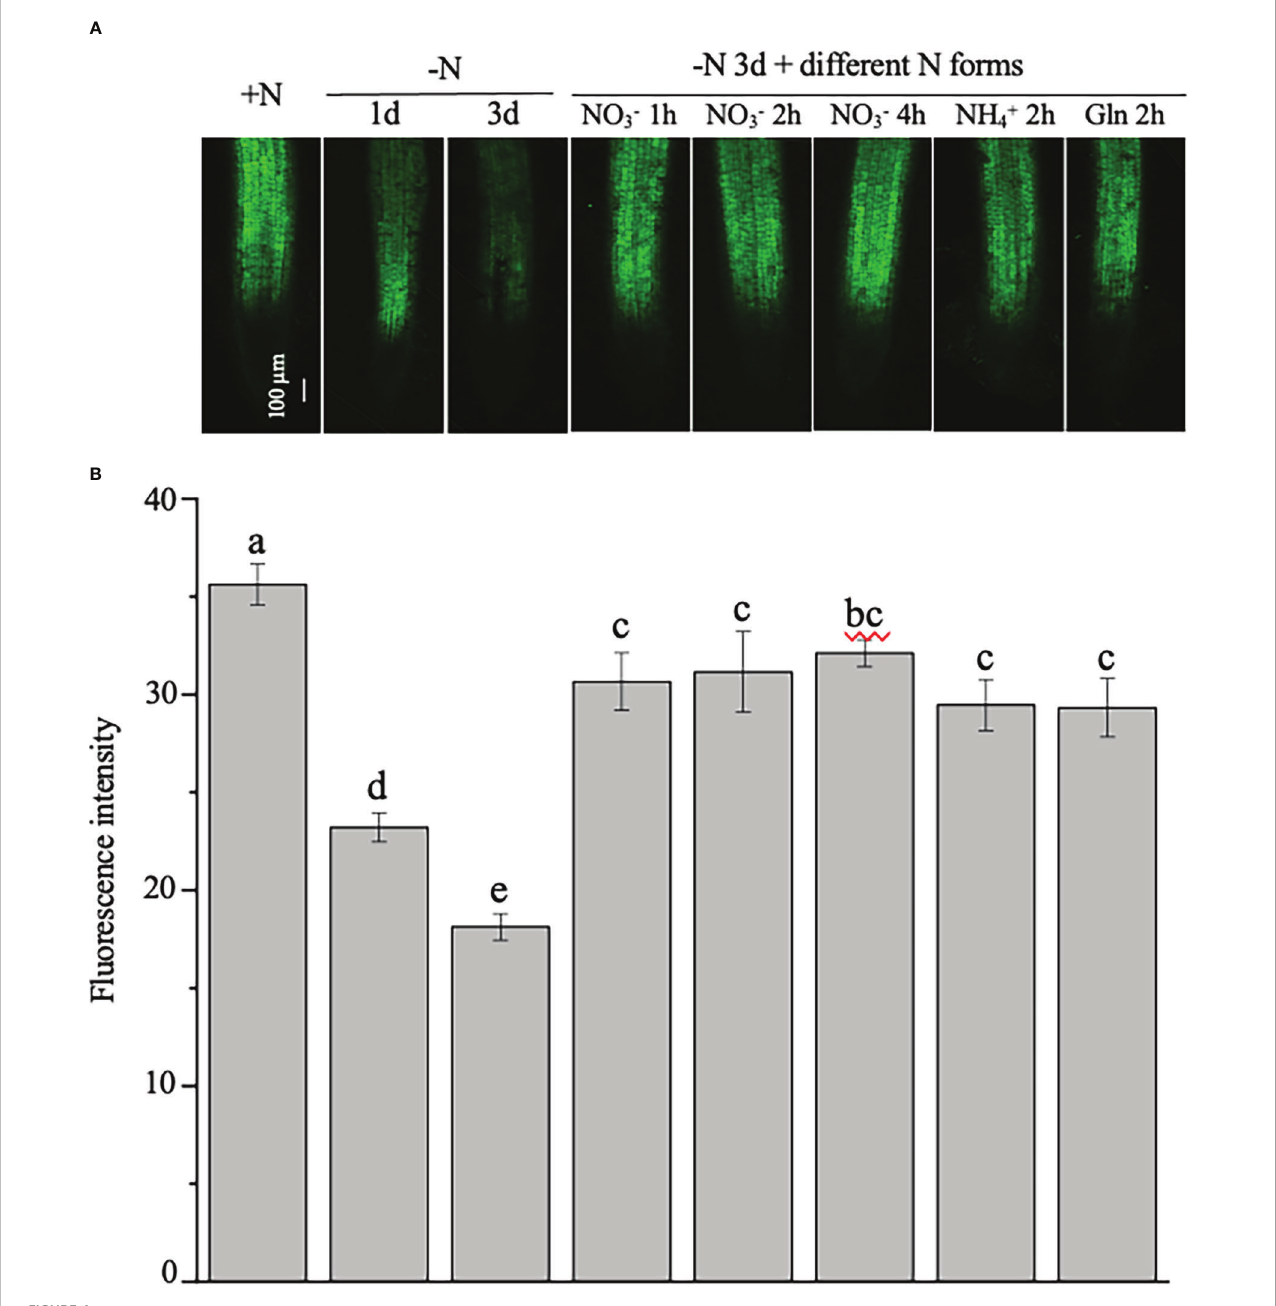
FIGURE 4 Examination of the regulation of the expression of the green fl uorescence protein (GFP) indicated Pro NtNRT1.1B activity by nitrogen in tobacco roots. Transgenic plants expressing GFP driven by a putative NtNRT1.1B gene promoter (Pro NtNRT1.1B ) were grown hydroponically with 1 mM NH 4 NO 3 as a nitrogen source for 4 weeks (see Materials and methods), and then were starved of N for 1 or 3 days. Furthermore, those plants subjected to 3 days ’ N starvation were resupplied with different N (2 mM) forms for different time periods. (A) Representative images of the GFP signal in roots. +N, continuous nitrogen-supply; – N, nitrogen starvation; Gln, glutamine. Confocal microscopic analysis is described in Materials and methods. Bar = 100 m m. (B) Quanti fi cation of green fl uorescence intensity in roots of plants treated with nitrogen regimes. The intensity of the green fl uorescence was photographed was then quanti fi ed using ImageJ software (see Materials and methods). The means of 15 biological replicates ± standard deviation (SD) ( n = 15 individual root samples) were plotted and different letters above the bars indicate statistically signi fi cant differences [ P< 0.05 by one-way analysis of variance (ANOVA) and a multiple comparison